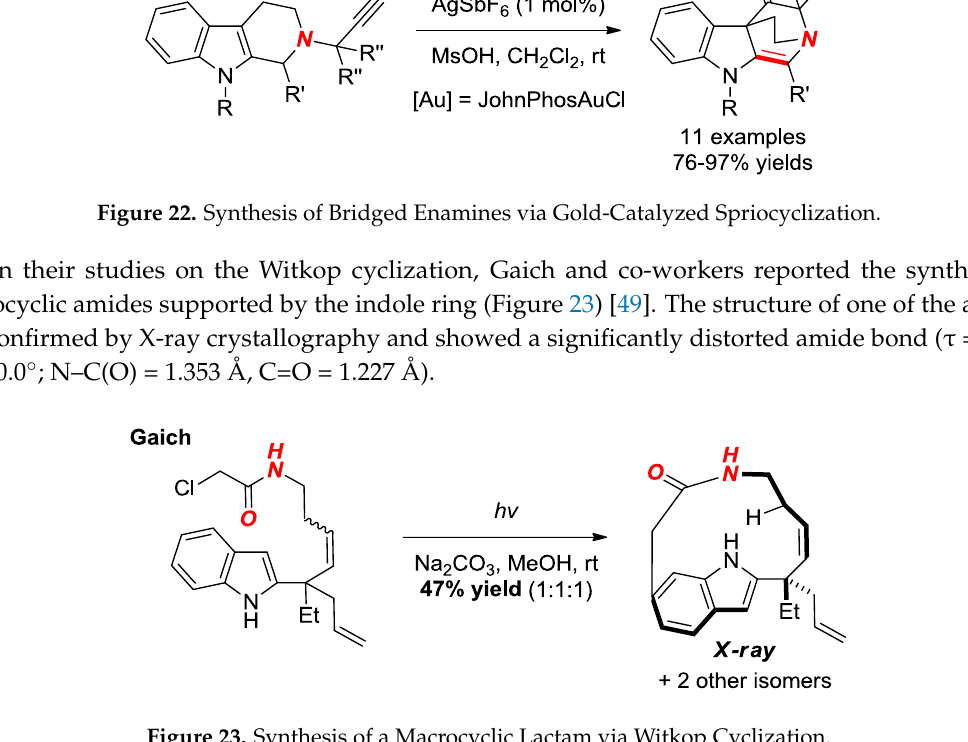
Figure 23. Synthesis of a Macrocyclic Lactam via Witkop Cyclization.